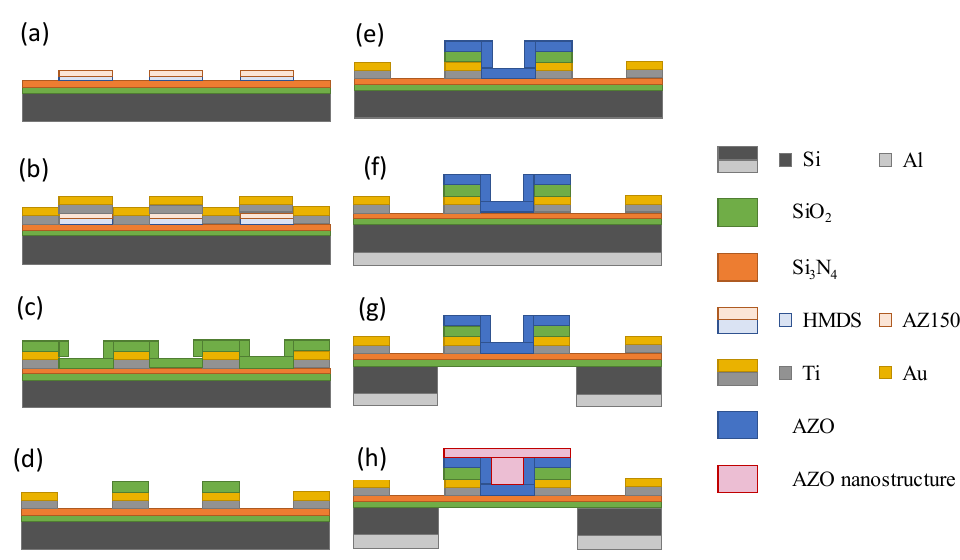
Figure 1. ( a – h ): Fabrication process of the MEMS microheater device.